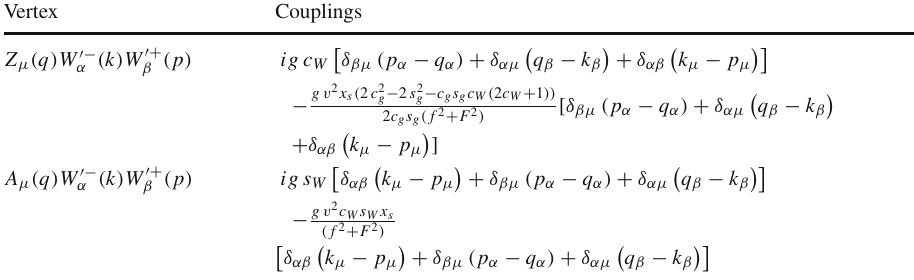
Table 9 Self-couplings of gauge bosons in the BLHM